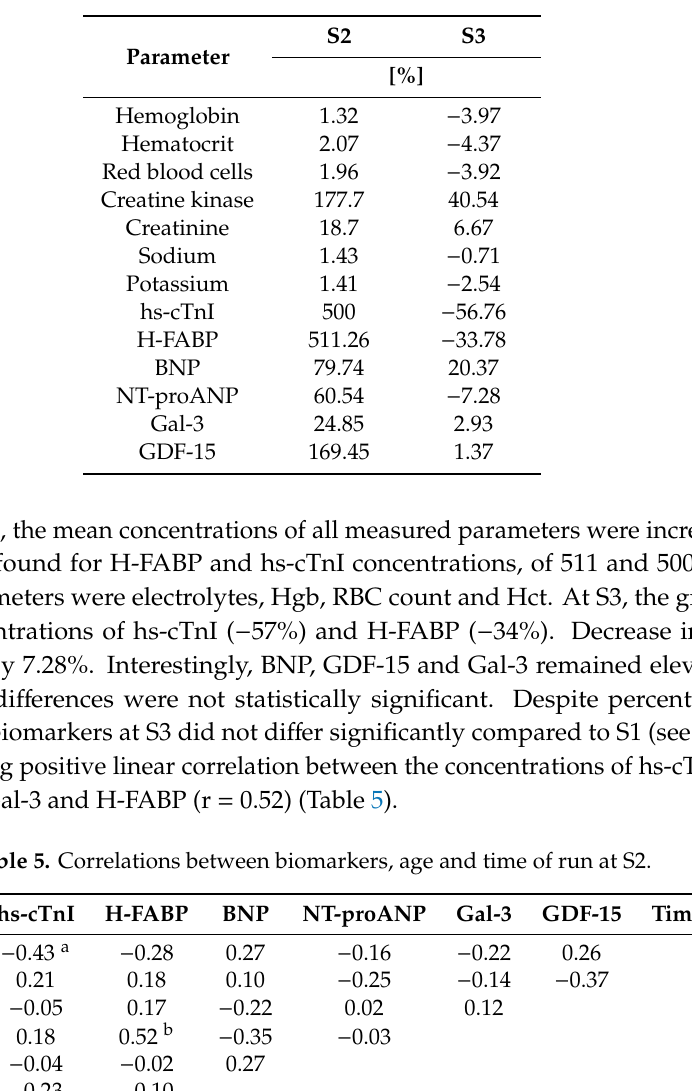
Table 4. Post-race changes in concentrations of hematological and biochemical parameters and biomarkers expressed as a percentage change from baseline (S1).